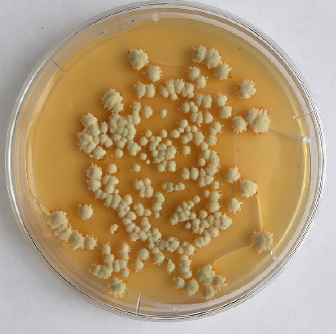
Figure 3. Colonies of Penicillium chrysogenum F-24-28.